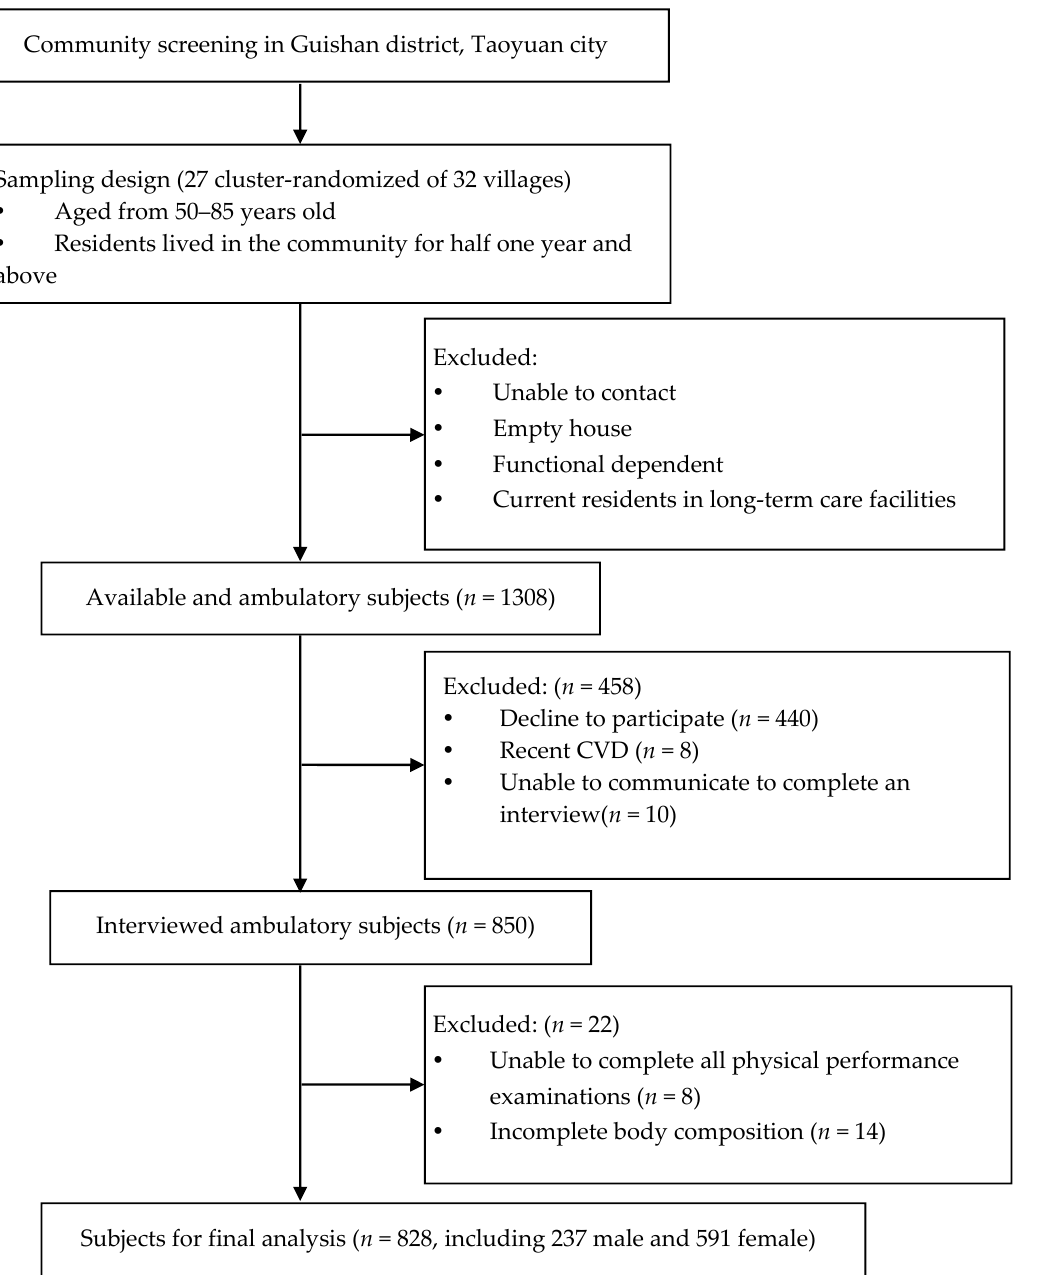
Figure 1. Study participant selection.